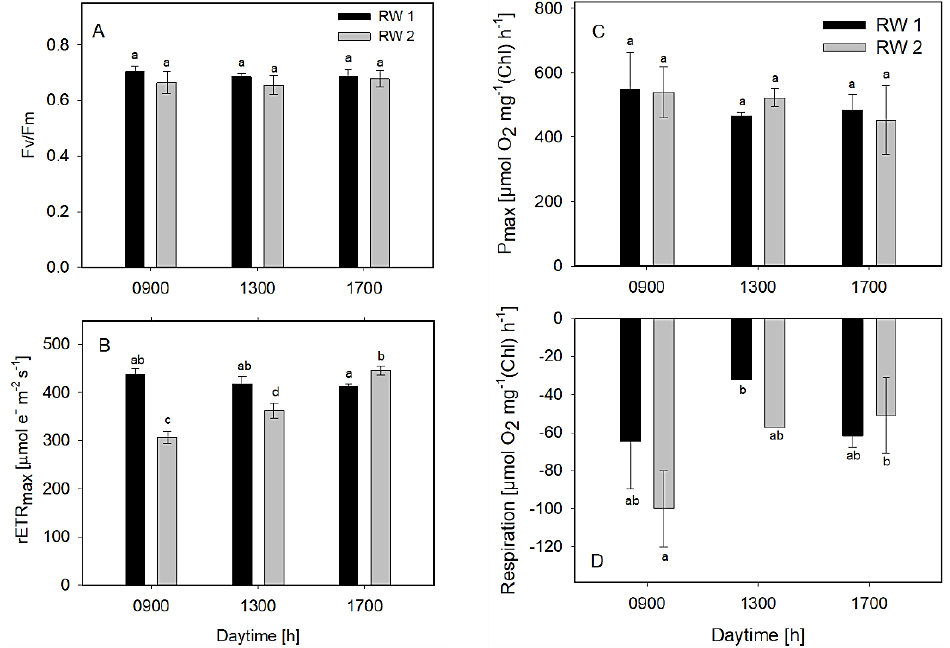
Figure 6. Variables Fv/Fm ( A ), rETR ( B ), oxygen production ( C ), and respiration ( D ) were estimated ex-situ using slow light-response curves of photosynthesis. The column designation is identical in all panels. The data were measured in the culture samples taken at 09:00, 13:00, and 17:00 h from the bioreactors RWP 1 and RWP2 during outdoor trials in Mérida. The mean values designated by the same letter did not differ significantly from each other.